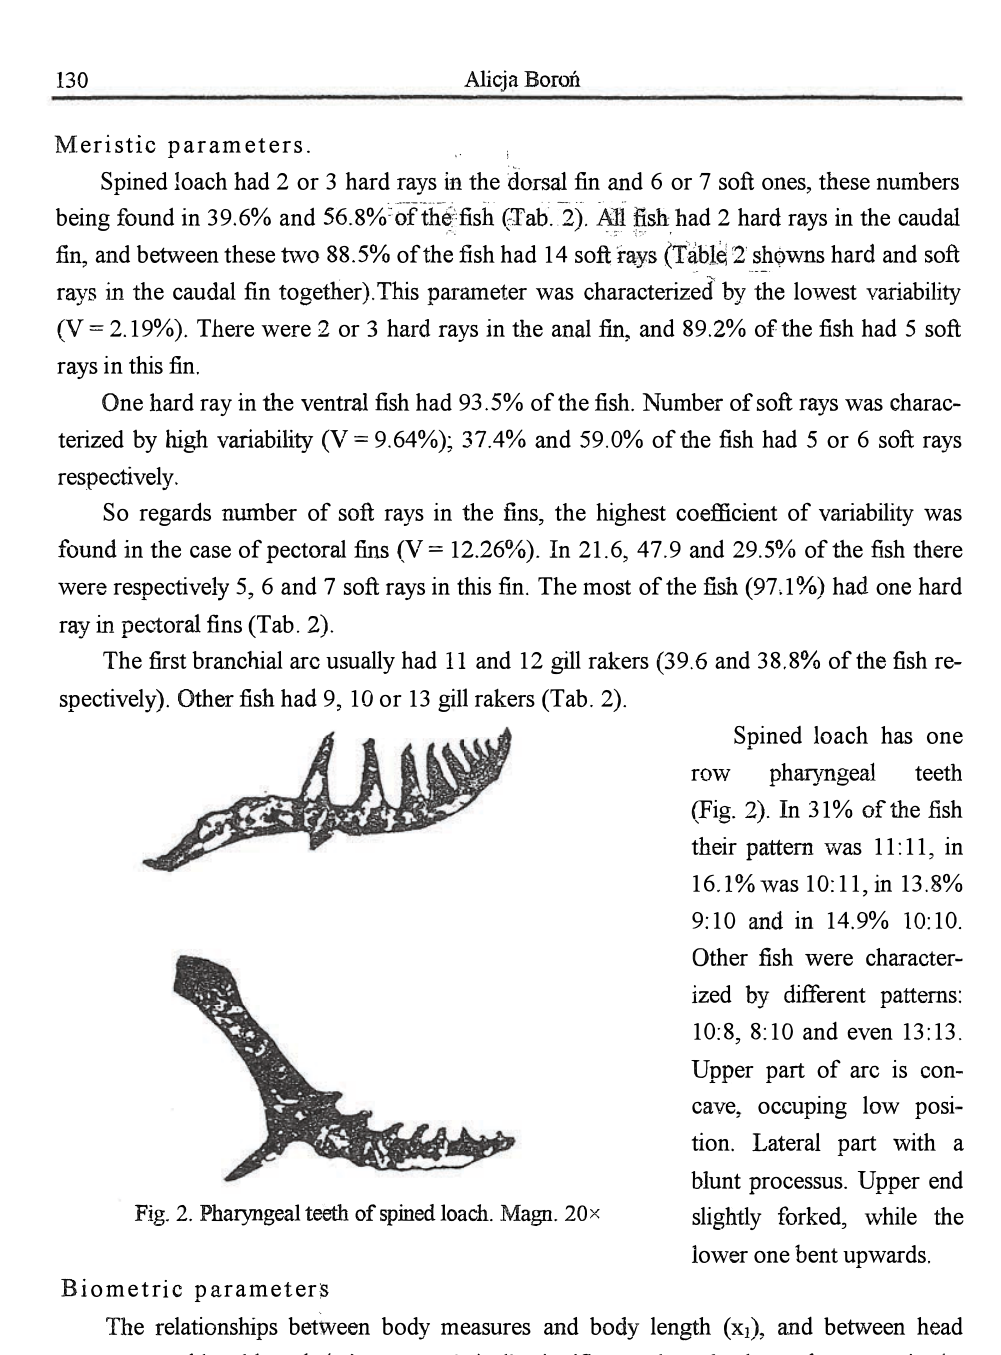
Fig. 2. Pharyngeal teeth of spined loach. Magn. 20 x